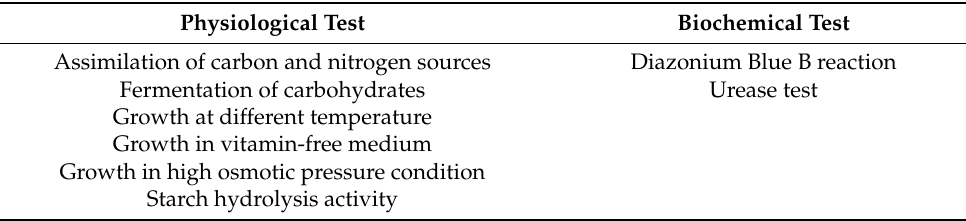
Table 7. Physiological and biochemical tests used for the characterisation of yeast.